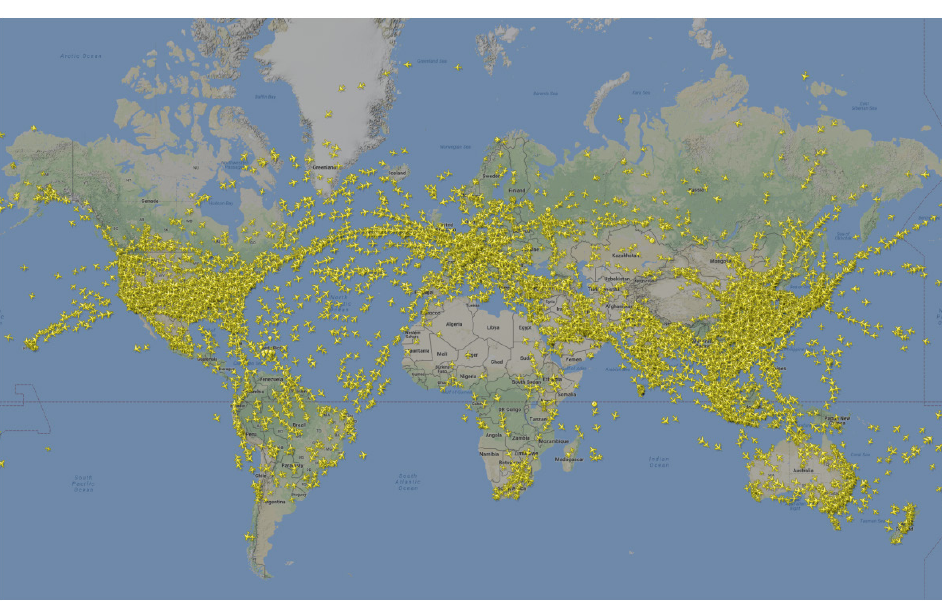
Fig. 2. A map of the airspace monitored by